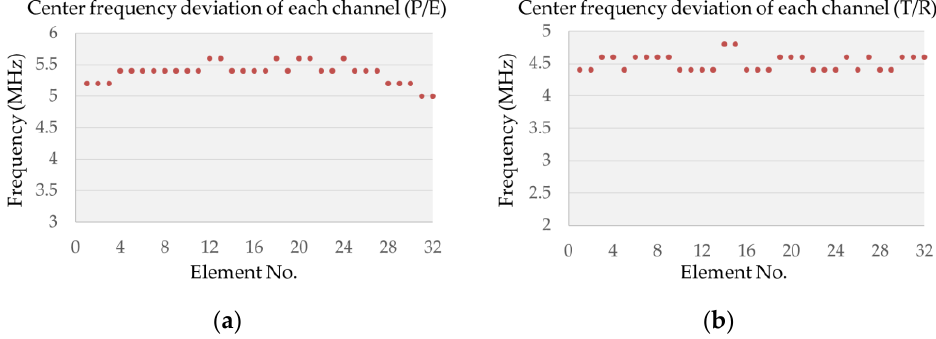
Figure 12. Center frequency for every FPAPr elements: ( a ) P/E type FPAPr; ( b ) T/R type FPAPr.